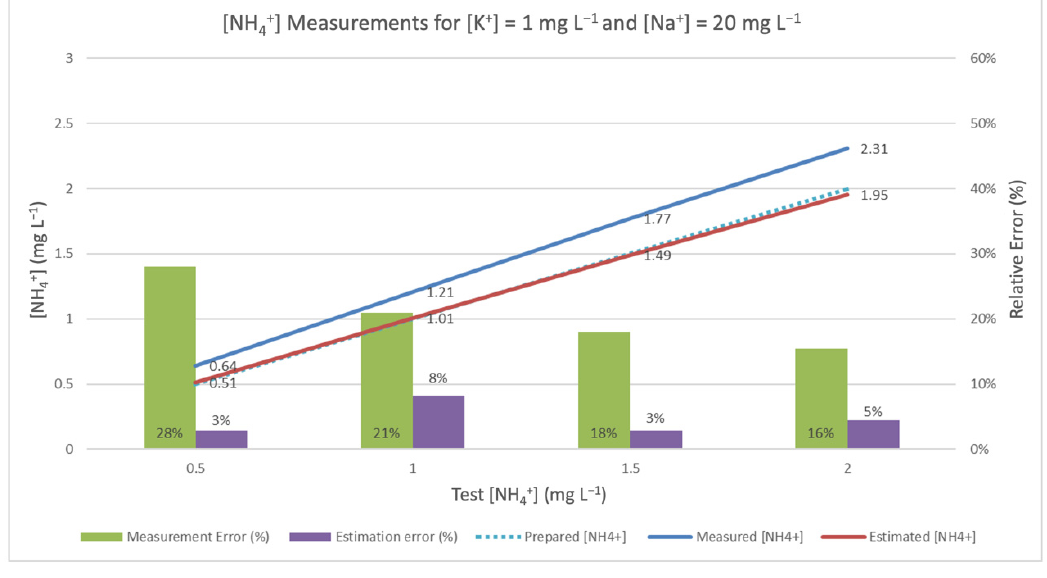
Figure 2. Measured and corrected [NH 4 + ] in the presence of [K + ] = 1.0 mg L − 1 and [Na + ] = 20 mg L − 1 .